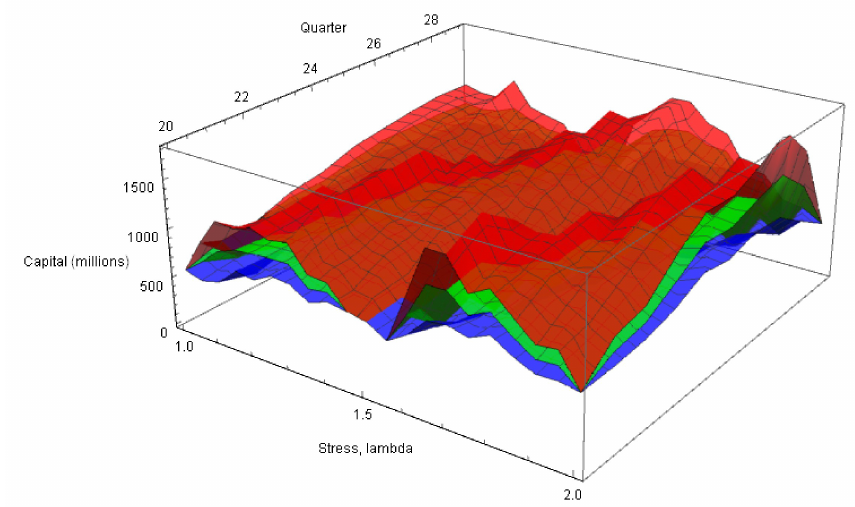
Figure A1. NonCPBP 95% confidence surfaces based on samples of size 10 for each point on each surface: upper µ + 1.96 σ (red), lower µ − 1.96 σ (blue), and mean µ